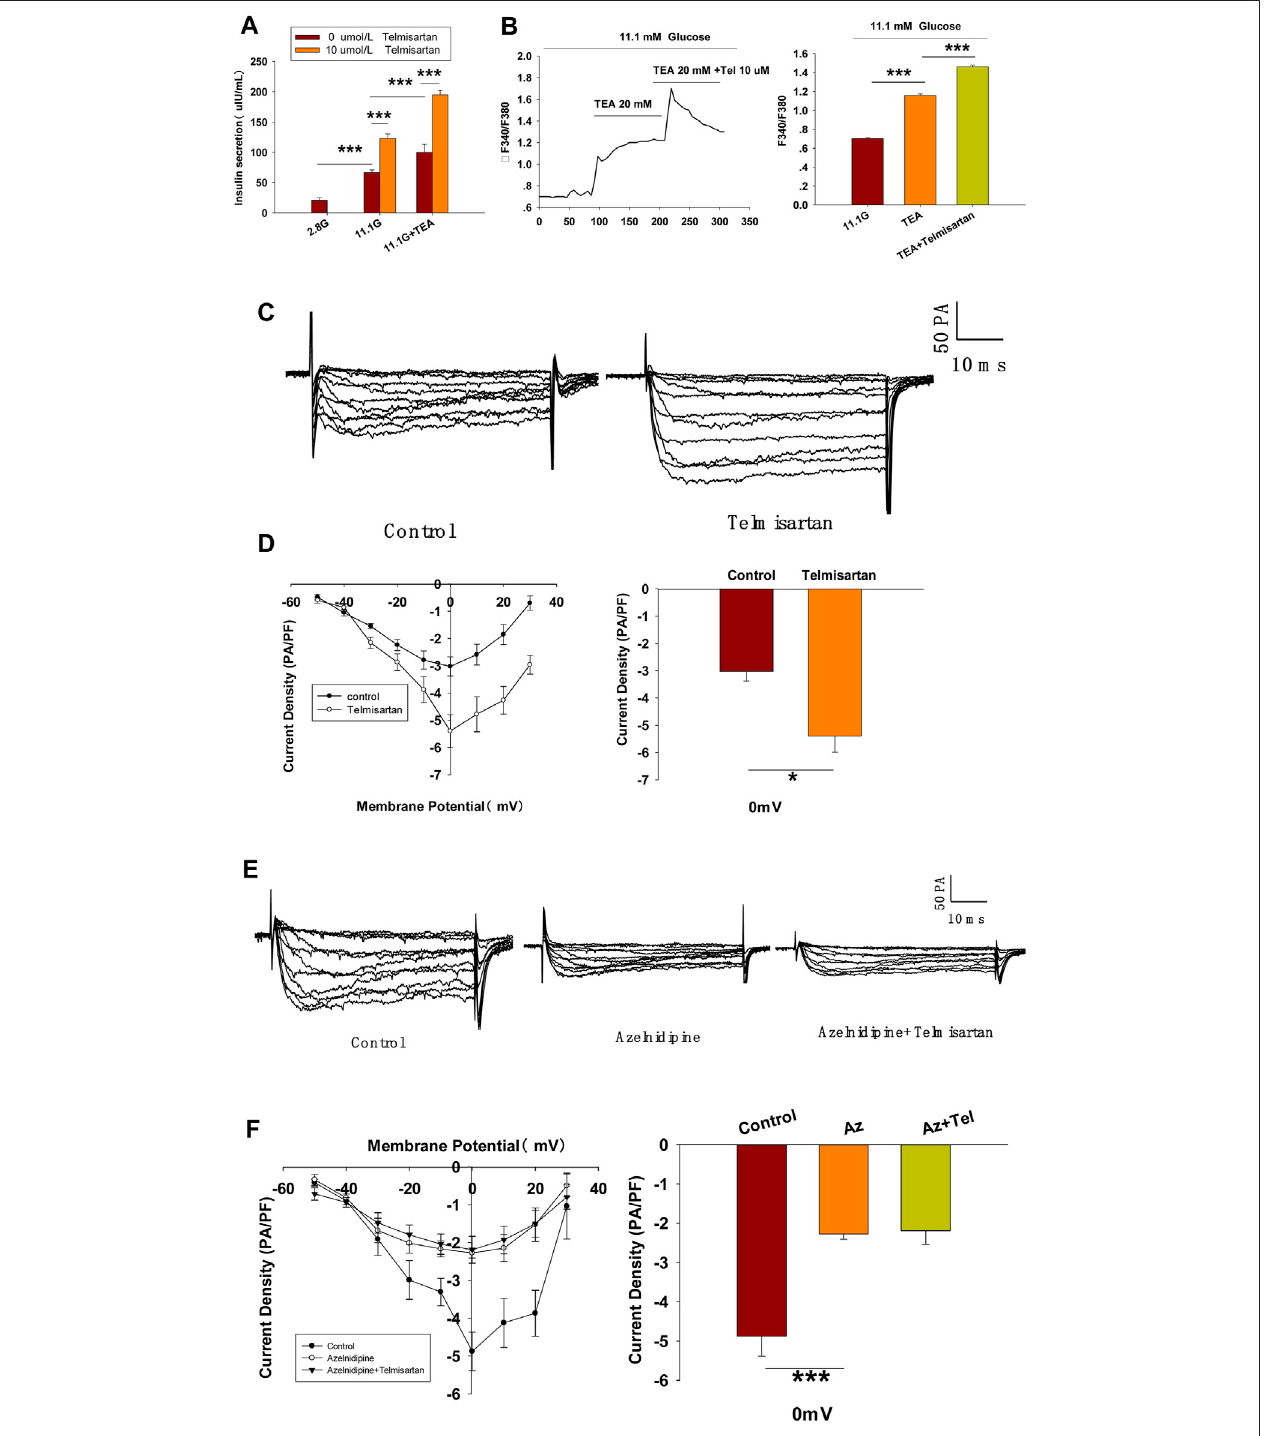
FIGURE 7| L-type VGCCs also mediatetelmisartan-induced insulin secretion and increase of[Ca 2+ ] i levels, independentof the AT-1 receptor and PPAR γ . (A) Rat islets were treated with telmisartan (10 μ M) in the presence or absence of TEA (20 mM) under 2.8 and 11.1 mM glucose conditions and insulin secretion was measured ( n (cid:1) 7tubesofislet).Allinsulinsecretionresultsarenormalizedtobasalsecretionat2.8Mmglucosecondition. (B) Thechangesof([Ca 2+ ] i )concentrationin β -cellstreated with20 mMTEA andincombinationwith10 μ Mtelmisartan(Tel)under11.1 mMglucose conditions,and theaveragevalueduring30sF340/F380spikesforeach test( n (cid:1) 9cells). (C) VGCCswererecordedinvoltage-clampmodewithtestpotentialsfrom − 50to30mVin10mVincrements.Representativecurrenttracesrecordedin control and telmisartan-treated (10 μ M) β -cells. (D) Current-voltage relationship curves of VGCCs and summary of the mean Ca 2+ current density recorded at 0